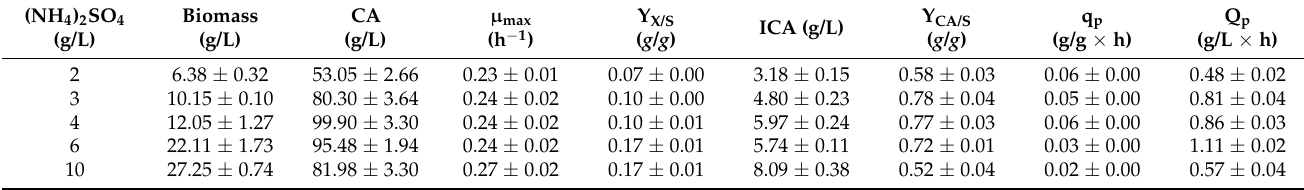
Table 1. The effect of nitrogen concentration on growth- and CA production parameters.